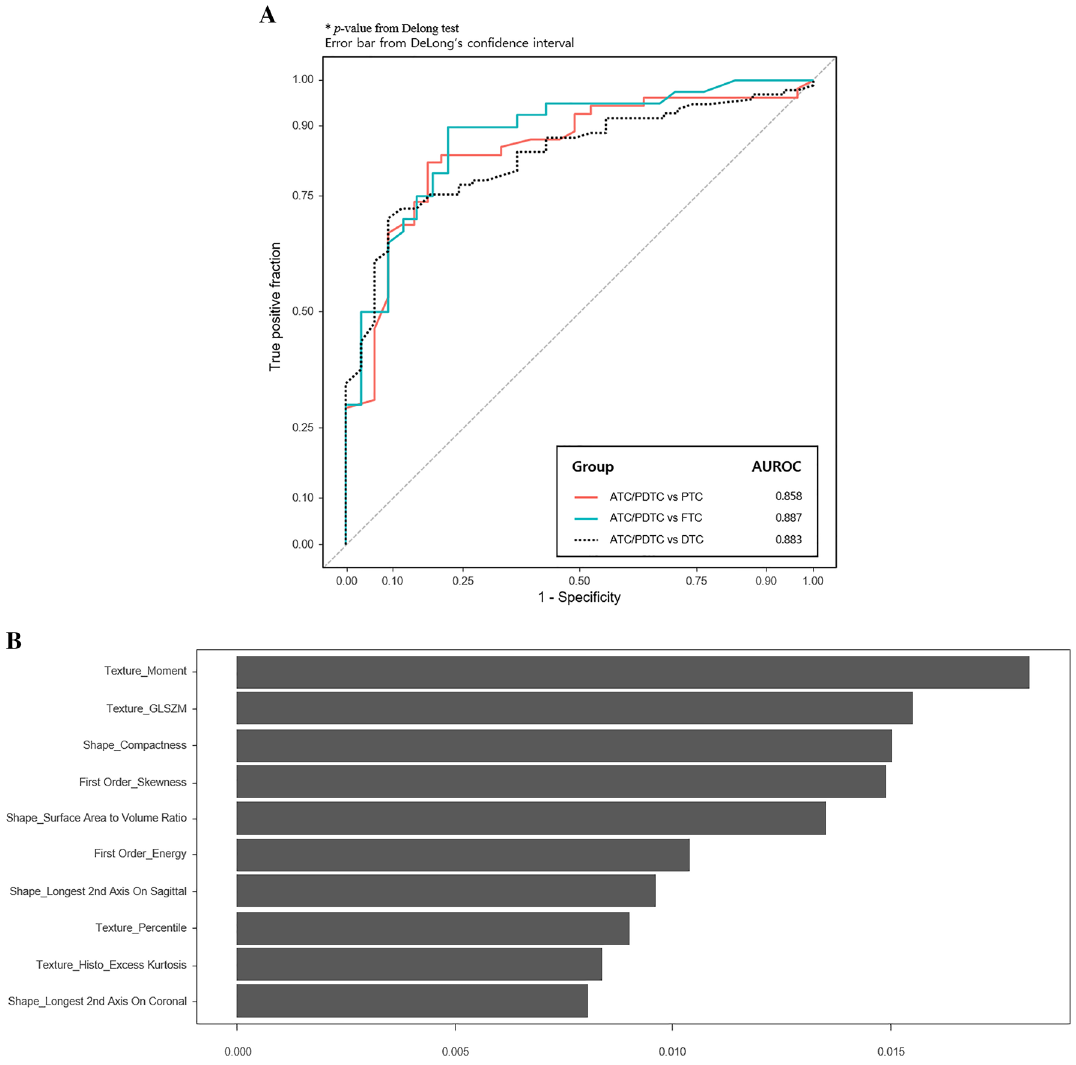
Figure 2. Receiver operating characteristic curves illustrating the diagnostic performance (for ATC/PDTC) of the models using radiomics alone ( A ) and the five most important features for distinguishing ATC/PDTC from DTC ( B